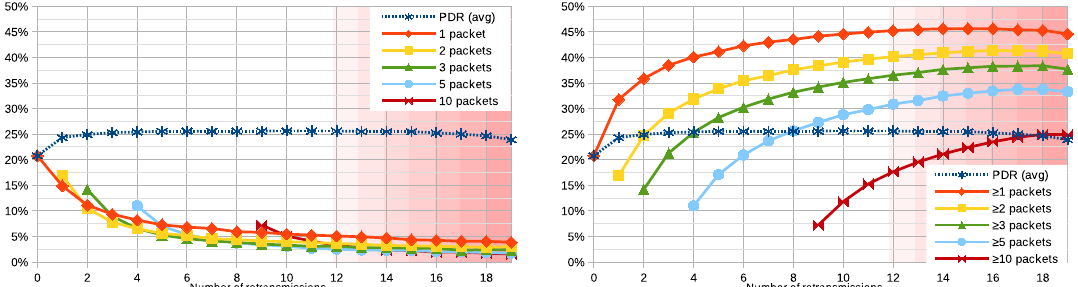
Figure 6. PDR and ratio of user nodes successfully communicating, in a function of the number of allowed retransmissions per node. The left graph plots the number of user nodes from which one, two, and three packets have been received. The right graph plots the number of user nodes from which ≥ 1, ≥ 2 and ≥ 3 packets have been